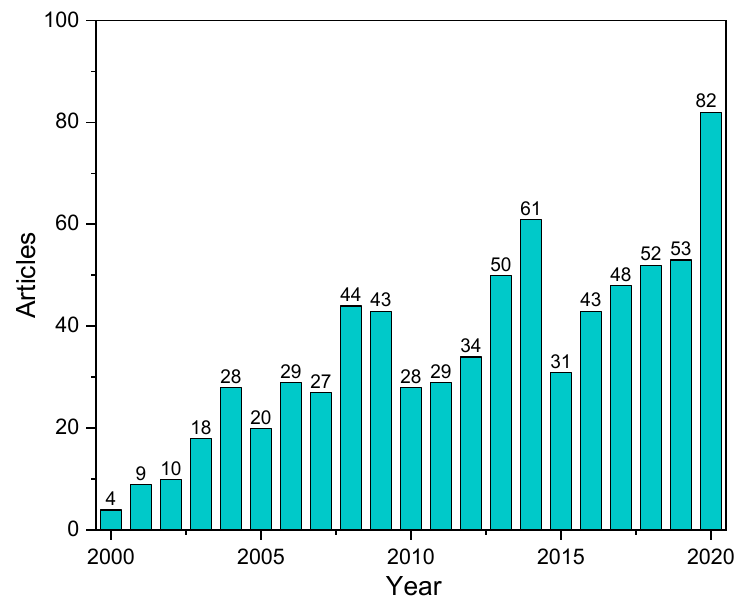
Figure 1. The number of publications on flame retardant metal polymer composite in the last two decades indicating the increasing interest from (Scopus, May 2021, Search: “Metal” and “Flame” and “Polymer”).